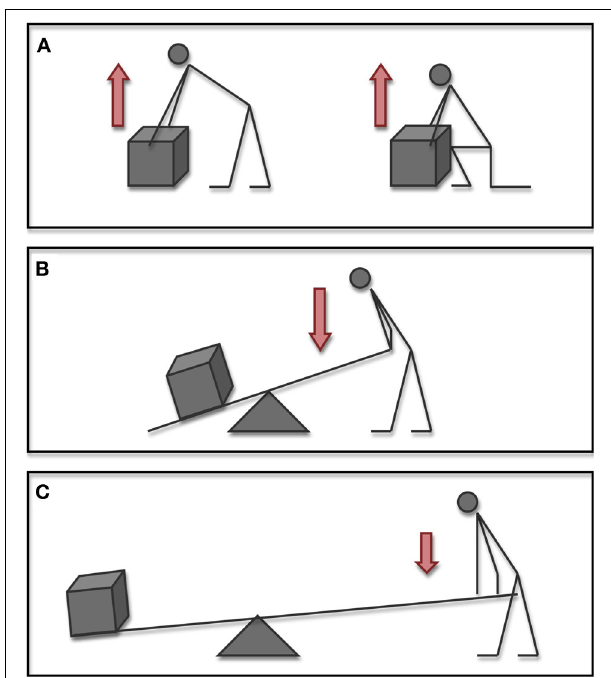
FIGURE 1 | In order to successfully learn goal directed actions, the actor must learn the functional dynamics of the task. Whilst different movements or tools may be used, each person is obliged to learn how body-object-environment relationships combine to satisfy task constraints. In these examples, the weight of the box (mass × gravity), indicated by the white arrow remains constant. The force applied by the actor (indicated here by the red arrow) may however vary as conditions change. (A) In the example of lifting a box, an individual may use any number of postural combinations. Successfully lifting the box requires only that the person generates enough force to overcome the mass of the box with the combined effect of gravity. (B) Upon introduction of a simple tool such as a lever, the dynamics of the task change considerably. (C) Adjusting relationships between tool-person-environment configurations may significantly change functional dynamics of the situation. Here this may be due to adjusting the location of the load and pivot, or alternatively by increasing the size of the lever.